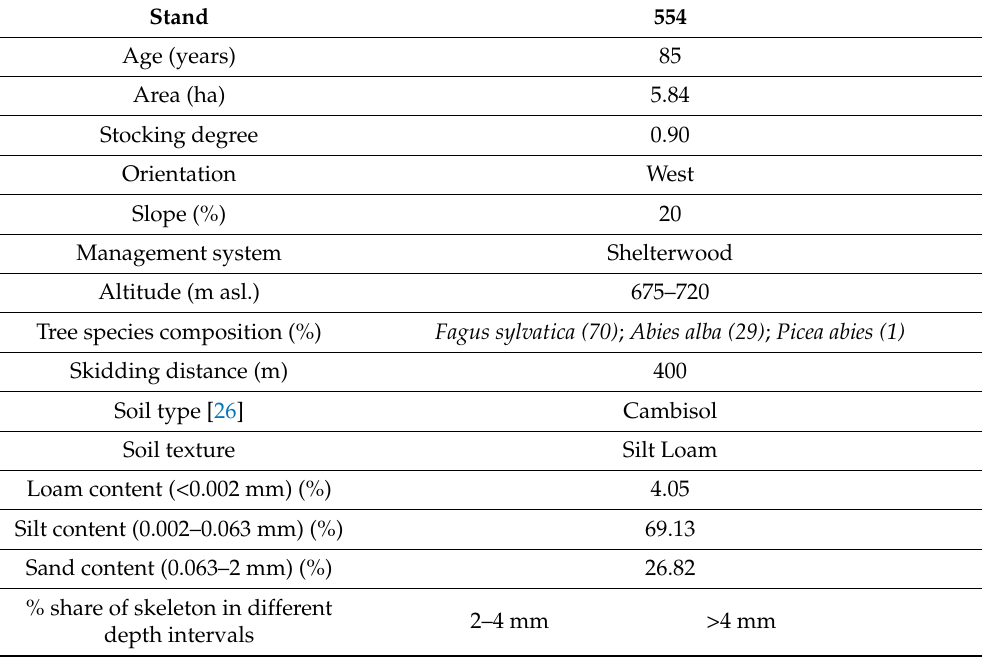
Table 1. Basic information on the observed forest stand and soil